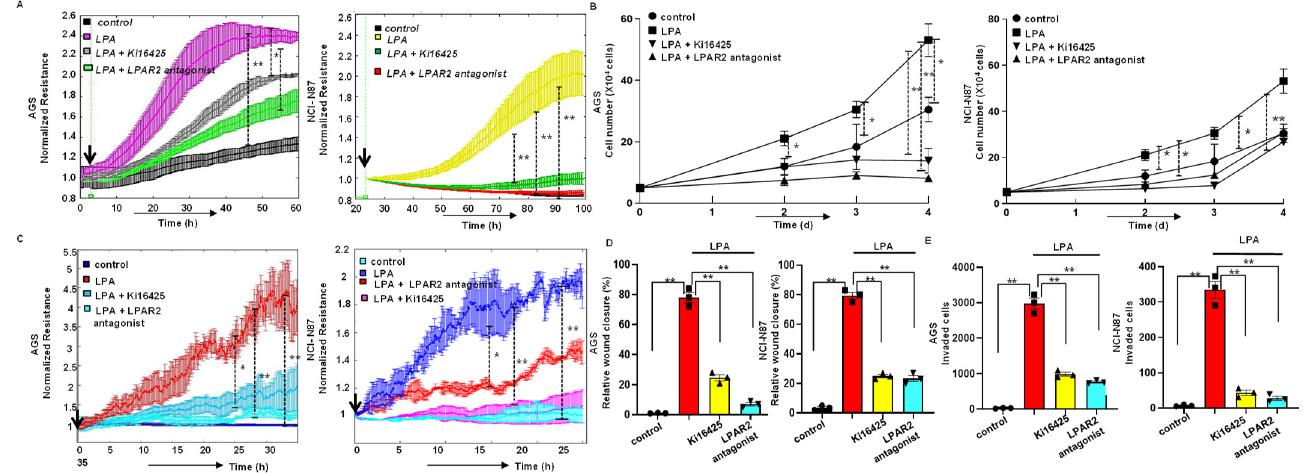
Figure 2. LPA increased the proliferation of the gastric cancer cell line through the LPAR2 receptor. ( A ) Effect of the LPAR-1/ LPAR2 and LPAR-3 inhibitor Ki16425 and LPAR2 antagonist on LPA-stimulated ECIS proliferation activity in the AGS and NCI-N87 cell line. Left panel: AGS cell line ( n = 3): blackline, control; purple line, LPA (10 µ M); grey line, LPA+ Ki16425; green line, LPA+ LPAR2 antagonist. Right panel: NCI-N87 cell line ( n = 3): black line, control; yellow line, LPA (10 µ M); green line, LPA+ Ki16425; red line, LPA+ LPAR2 antagonist. ( B ) Hemocytometer proliferation assay showing that both the LPAR2 antagonist and Ki16425 significantly reduced LPA-induced proliferation activity in the AGS cells (left panel) or NCI-N87 cells (right panel). All values are mean ± SD ( n = 3). * p < 0.05, ** p < 0.01; one-way analysis of variance (ANOVA) followed by the Bonferroni post hoc test. ( C – E ) Effect of the LPA receptor antagonists on LPA-induced migration and invasion of the gastric cancer cell line. ( C ) Left panel: ECIS wound healing assay analysis of the effect of Ki16425 on LPA-induced migration activity in the AGS cell line. Dark blue line, control; red line, LPA (10 µ M); dark turquoise blue line, LPA+ Ki16425; and light turquoise blue line, LPA+ LPAR2 antagonist. Right panel: ECIS wound healing assay in NCI-N87 cell. Light turquoise blue line, control; dark blue line, LPA (10 µ M); red line, LPA+ Ki16425; purple line, LPA+ LPAR2 antagonist. ( D ) Scratch assay analysis of the effect of Ki16425 and LPAR2 antagonist on LPA-induced migration in the gastric cancer cells. Quantified wound closure rate after 24 h of exposure to LPA in the presence and absence of LPA inhibitors in AGS (left) or NCI-N87 (right) cells. ( C ). LPA receptor antagonists reduced LPA-induced invasive activity in gastric cancer cells. Quantification of the results of the invasion assay. Left panel: AGS cell line; right panel: NCI-N87 cell line. All values are mean ± SD ( n = 3). ** p < 0.01; one-way ANOVA) followed by the Bonferroni post hoc